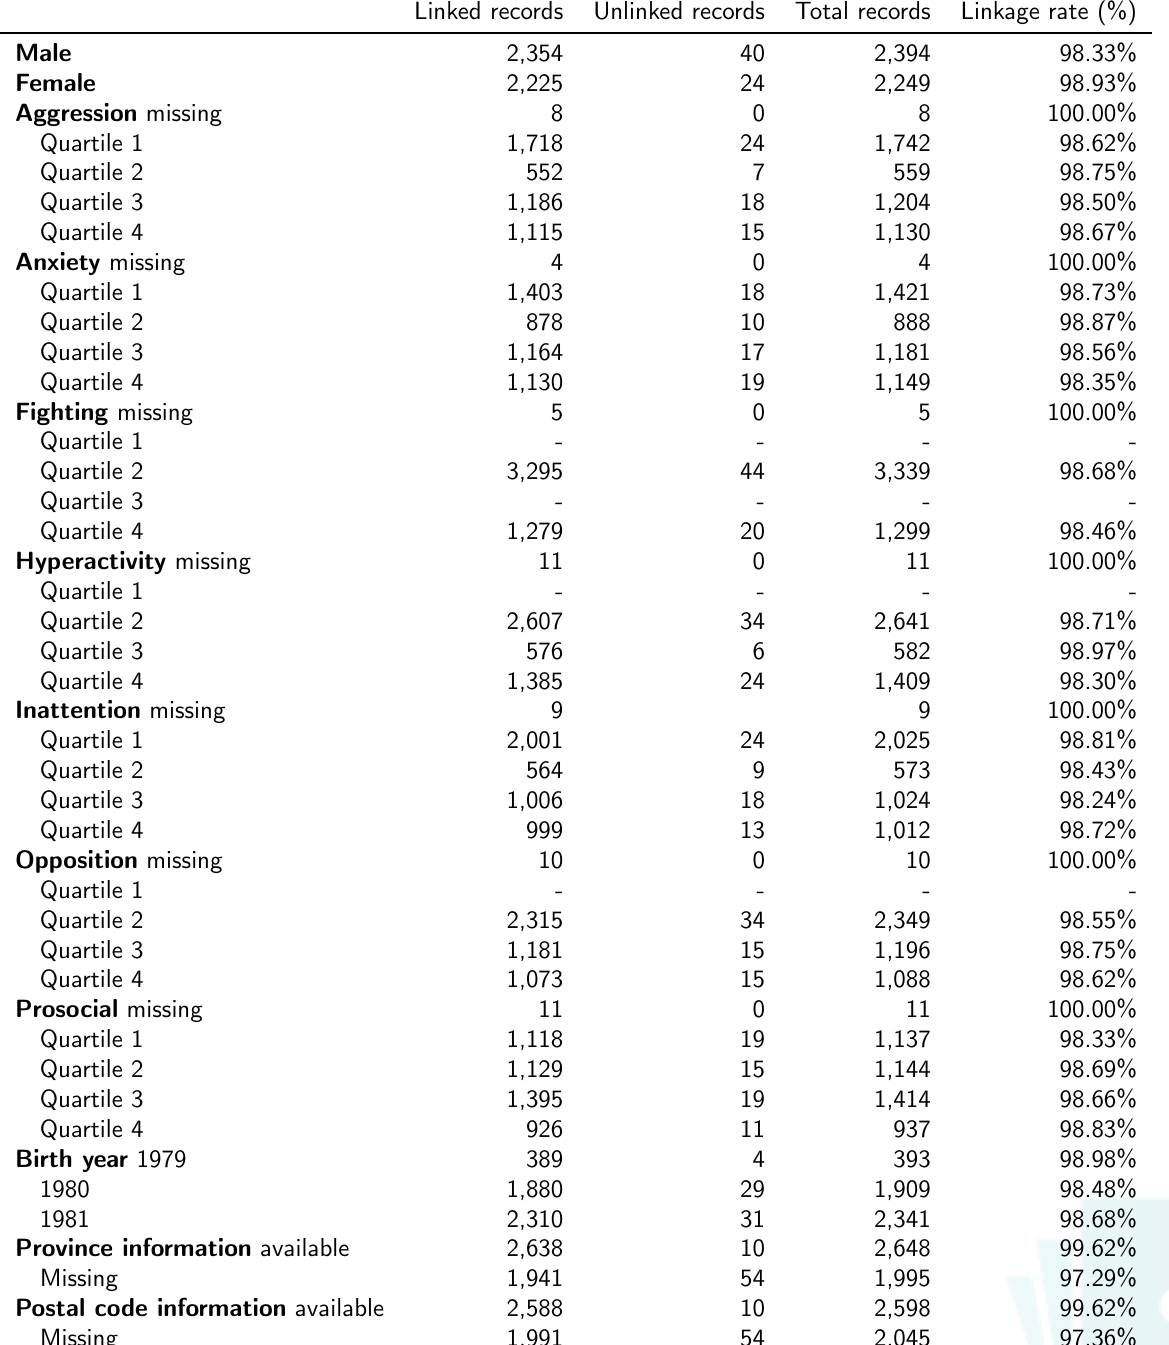
Table 3: Linkage rates for the QLSKC cohort to the DRD Linked